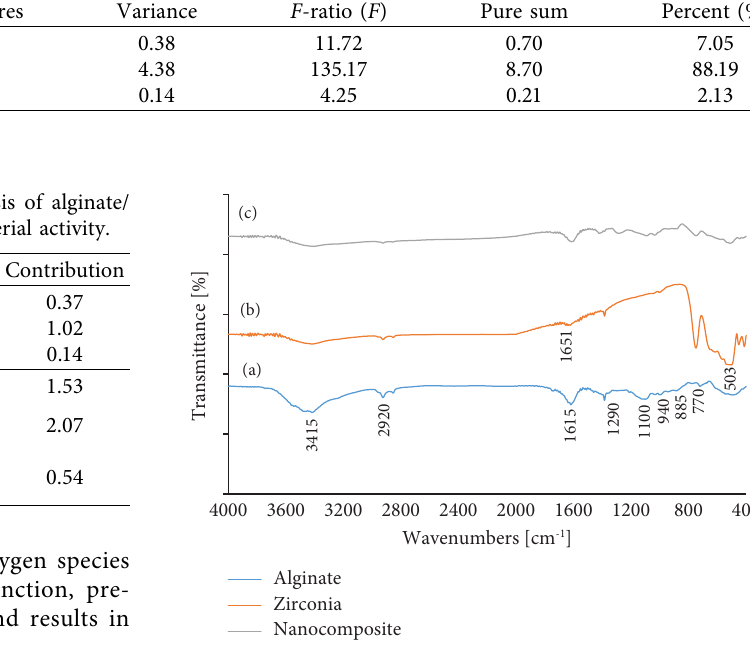
Figure 1: Fourier transform infrared spectroscopy (FTIR) spectra of the alginate biopolymer (a), zirconia NPs (b), and alginate/ zirconia nanocomposites